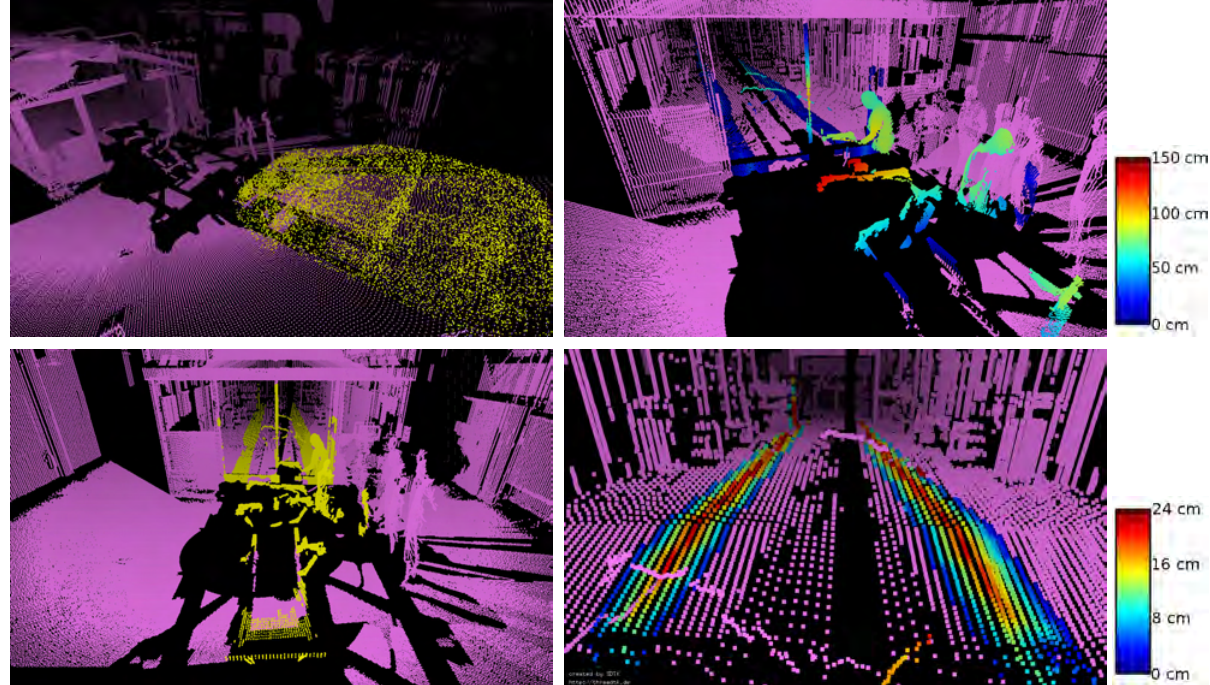
Figure 7: Upper Left: a view of two point clouds (environment and car). Lower Left: two separated point clouds (non-colliding and colliding points). Right Column: Color-coded depths of